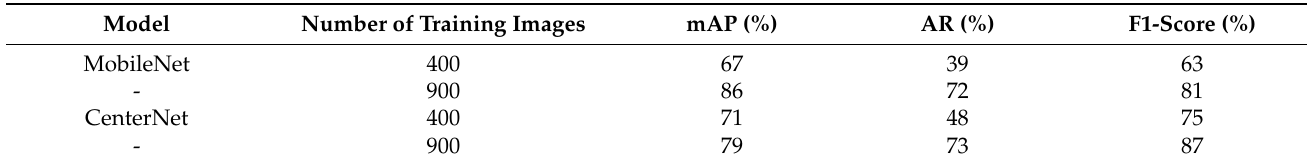
Table 1. Mean average precision (mAP), average recall (AR) and mean F1-score results for the MobileNet and CenterNet models in cotton stand counting using UAS